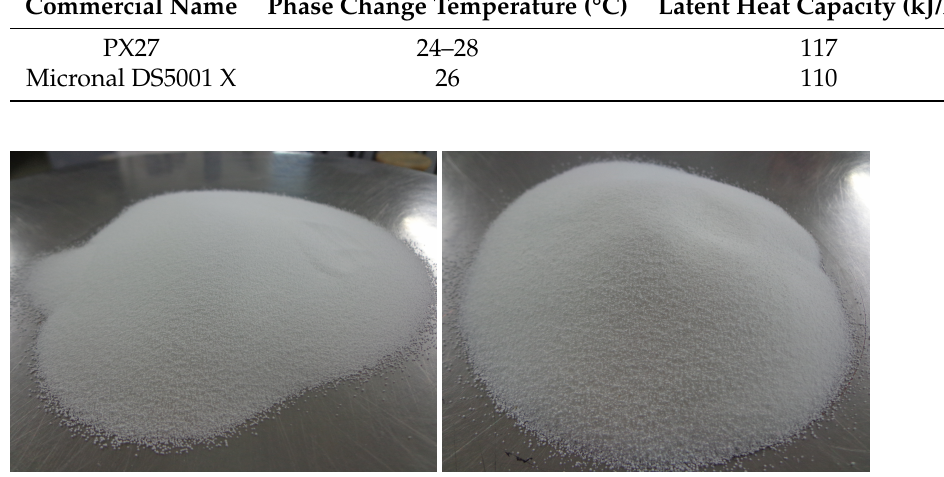
Figure 1. Microencapsulated paraffin based PCM: DS5001 X ( left ) and PX27 ( right